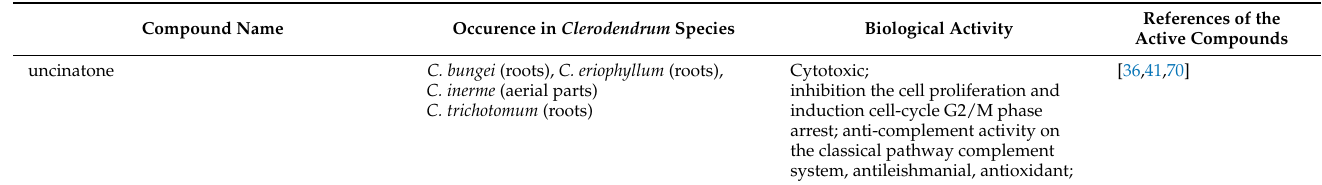
Table 14. The biological activities of diterpenoids isolated from Clerodendrum